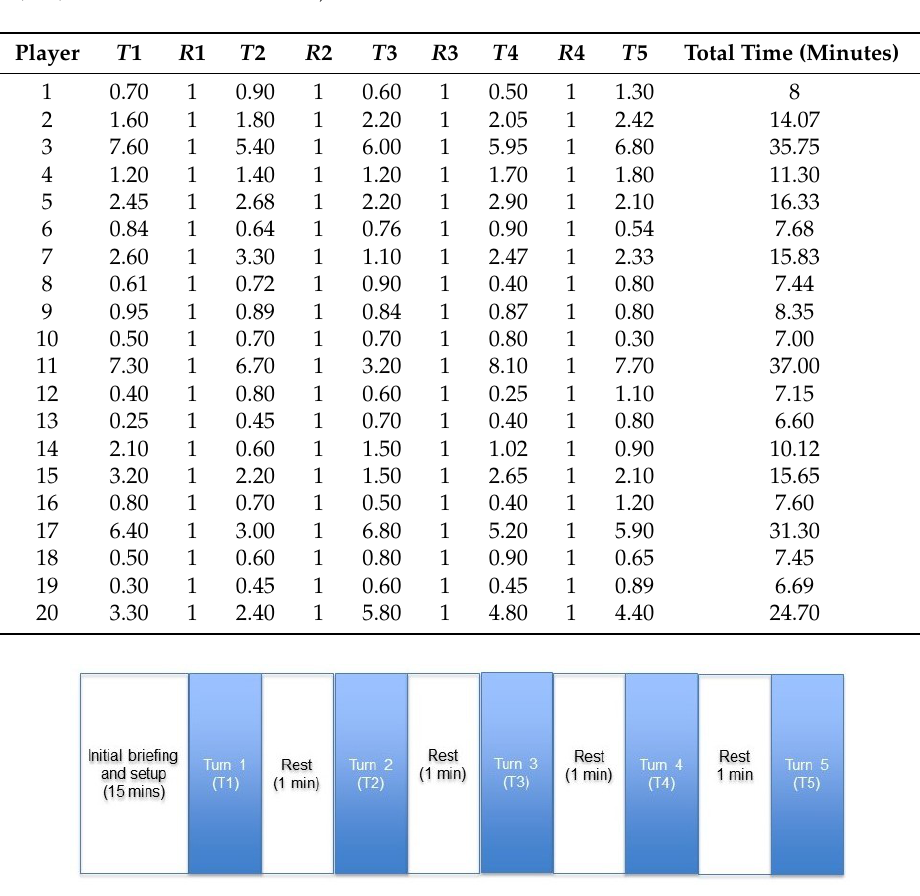
Table 1. The time taken for different turns by all users involved in the study (times for T 1, T 2, T 3, T 4, T 5, R 1, R 2, R 3 and R 4 are in minutes).